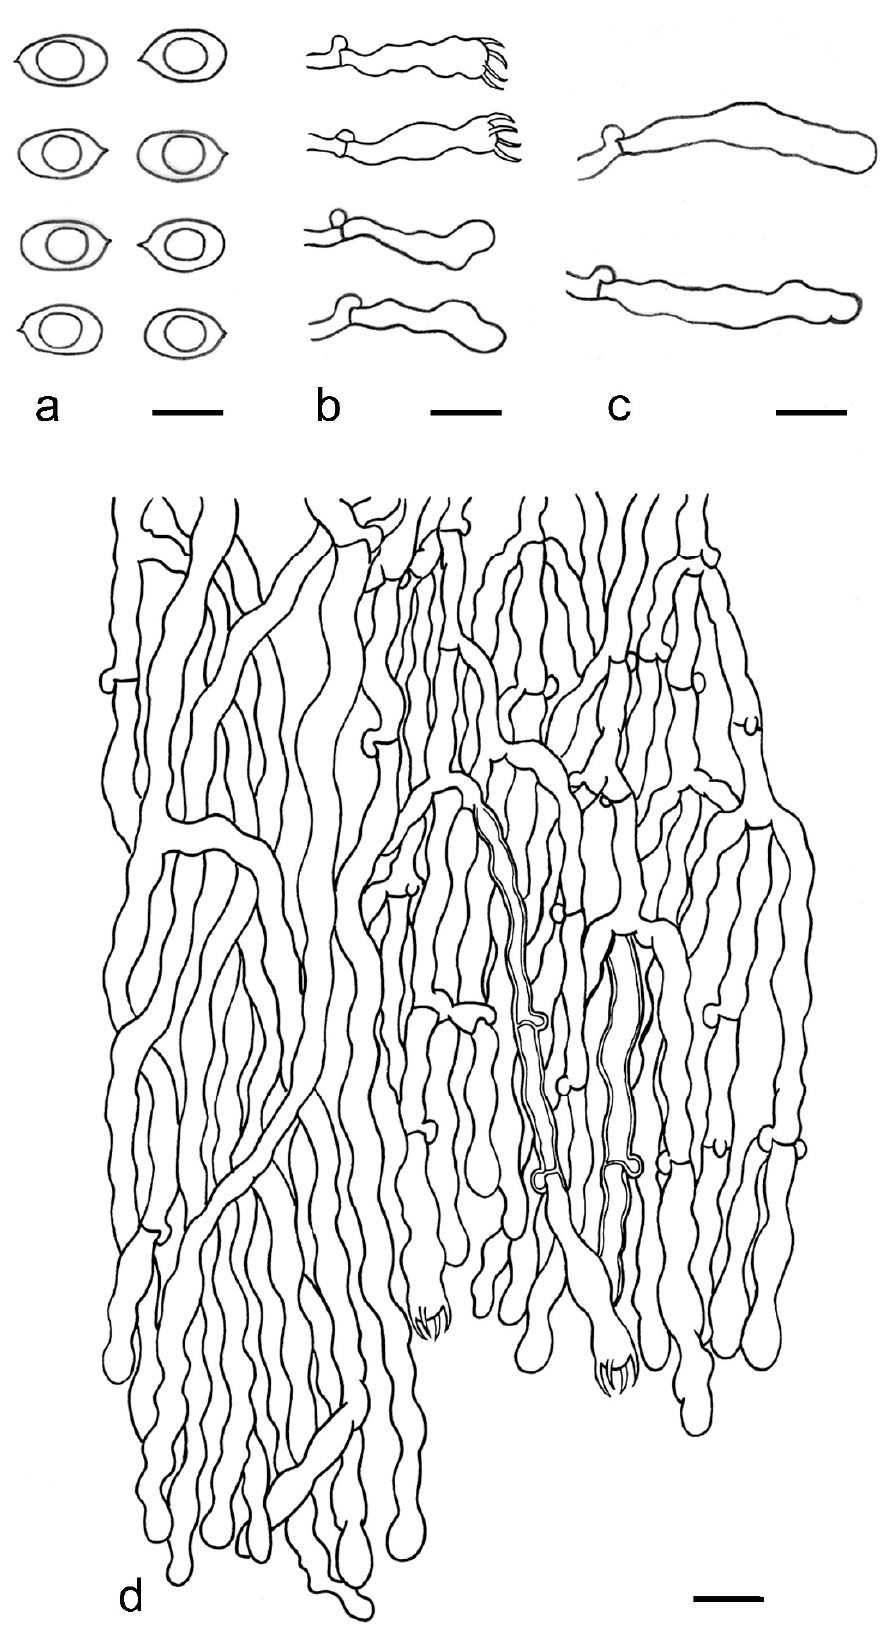
Figure 25. Microscopic structures of Xylodon damansaraensis (drawn from the holotype). ( a ) Basidiospores; ( b ) basidioles; ( c ) clavate-sinuous to submoniliform cystidia; ( d ) a section of the basidiocarp.—Scale bars: a = 5 μ m; b–d = 10 μ m.